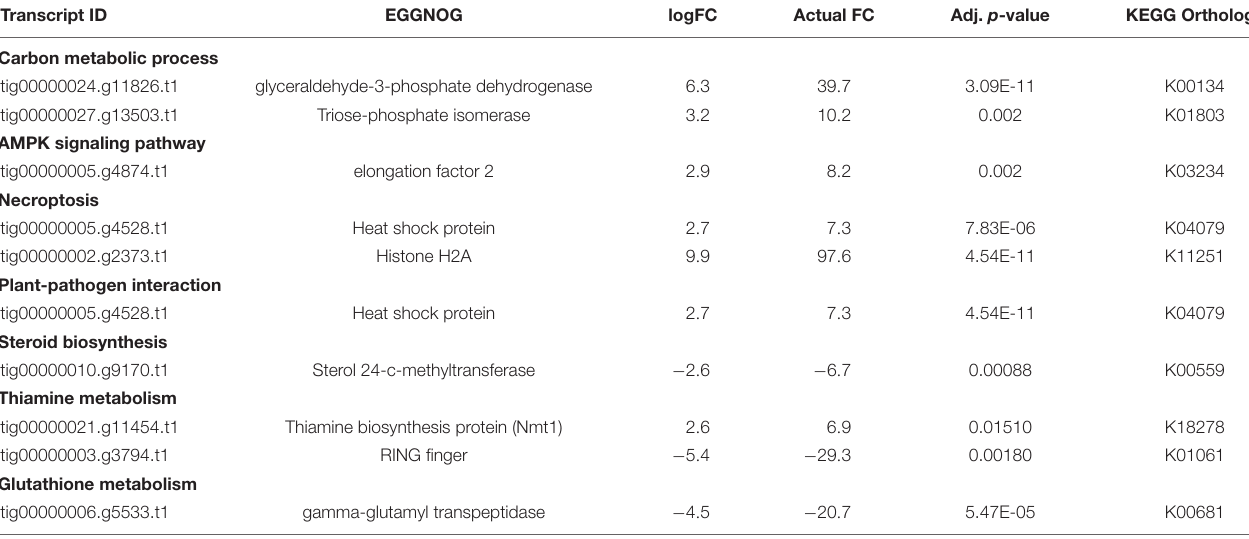
TABLE 2 | Significant DE genes under various metabolic pathways for pathogen comparison 3 ( Figure 1 ): CTDsap vs. CTDscr.